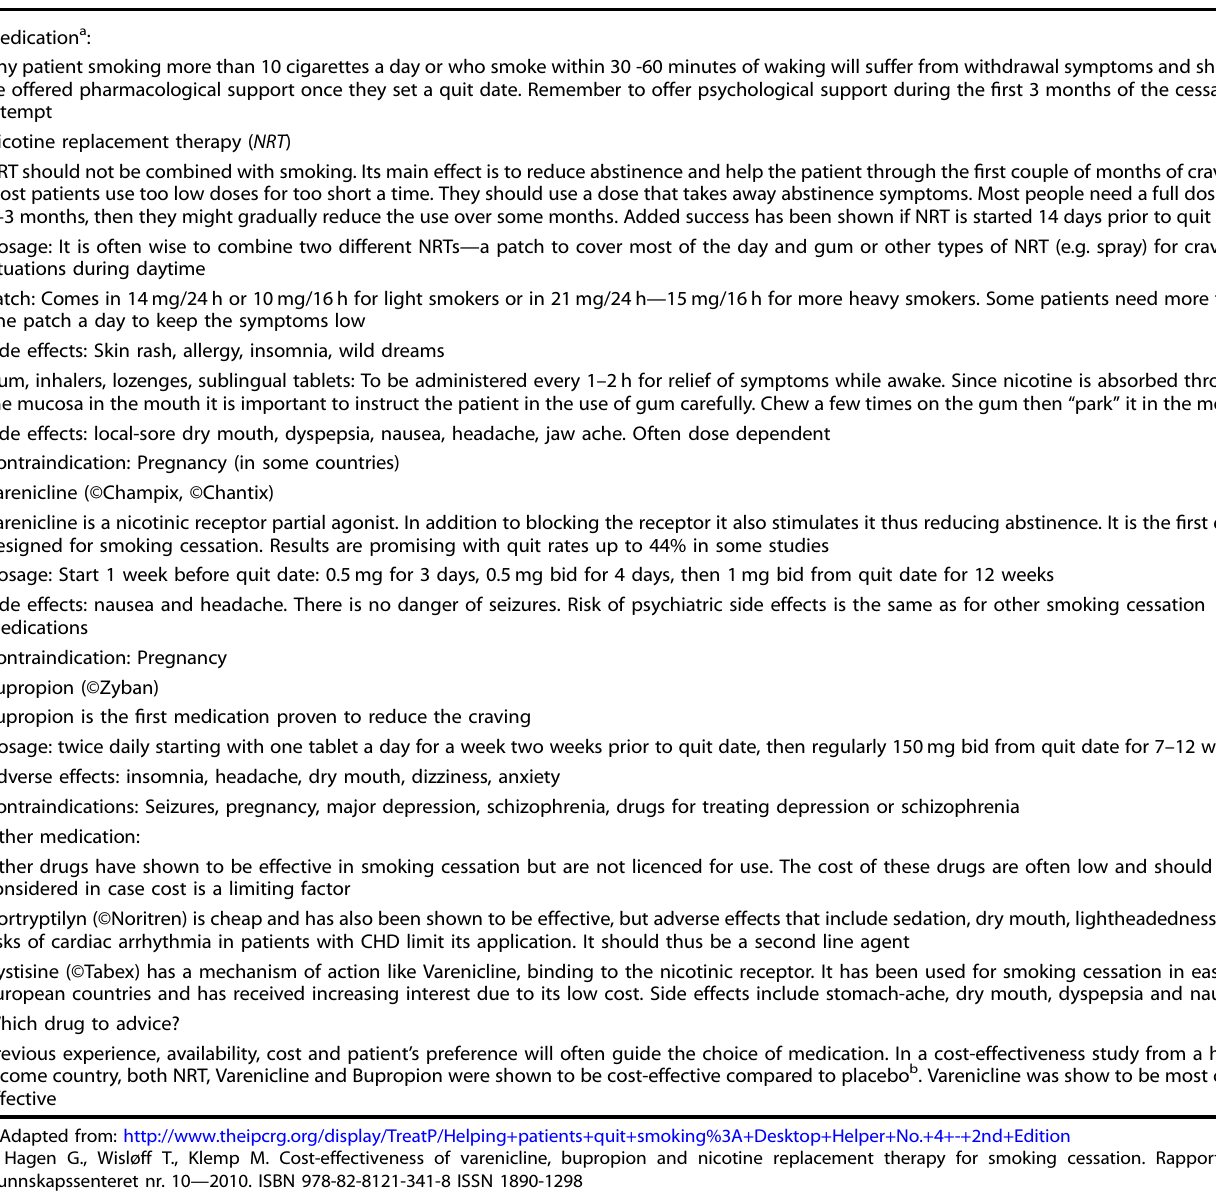
Table 5. Pharmacotherapy for nicotine dependence Medication a